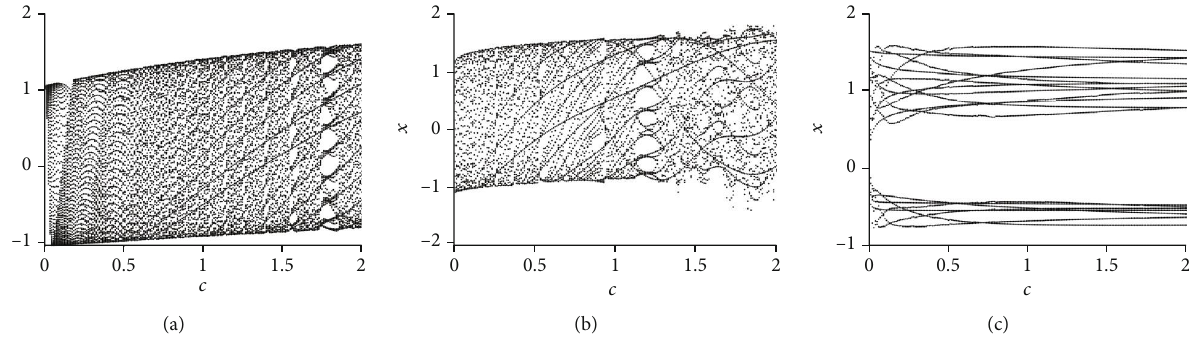
Figure 2: The bifurcations in system (1) versus parameter c with fractional orders (a) ϖ = 1 , (b) ϖ = 0 : 99